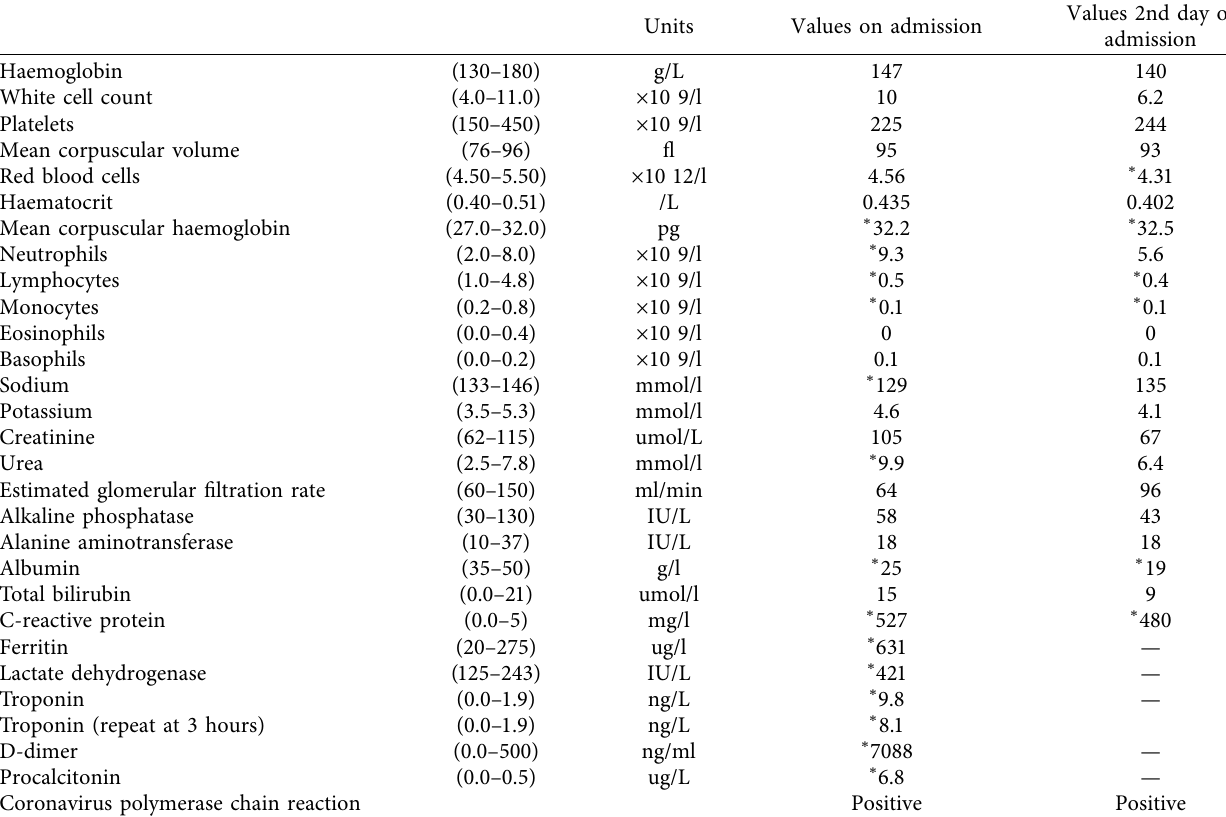
Table 1: Laboratory investigations detailing a positive coronavirus swab test and initial hyponatremia, ∗ indicates abnormal